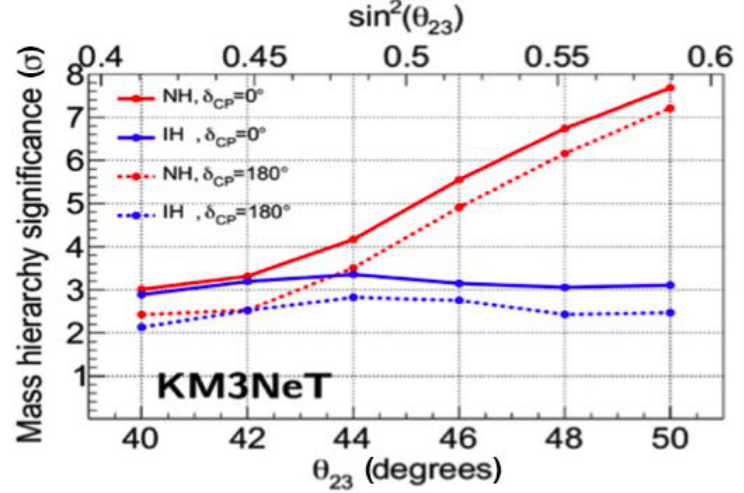
Figure 8. The KM3NeT-ORCAsensitivity to the neutrino mass hierarchy after three years of data taking with a full